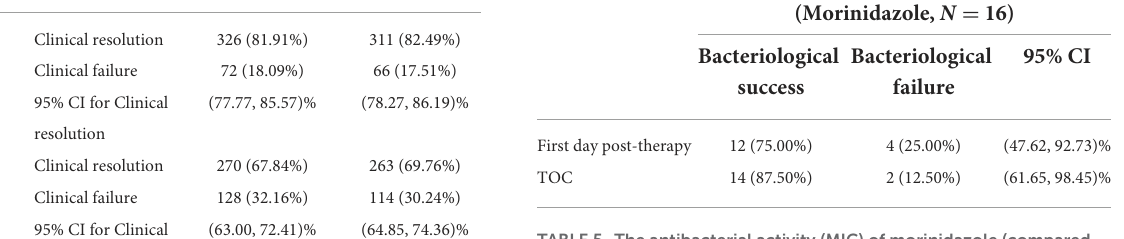
TABLE 5 The antibacterial activity (MIC) of morinidazole (compared with those of ornidazole and metronidazole) against anaerobes in vitro